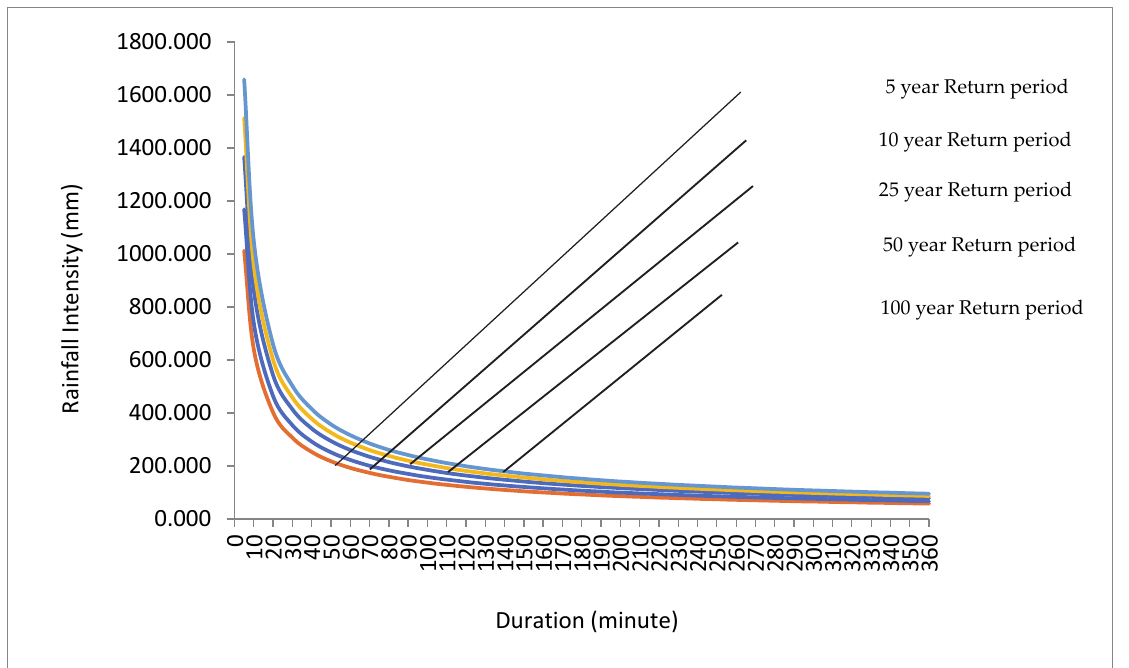
Figure 2. Intensity Duration Frequency (IDF) Curve.